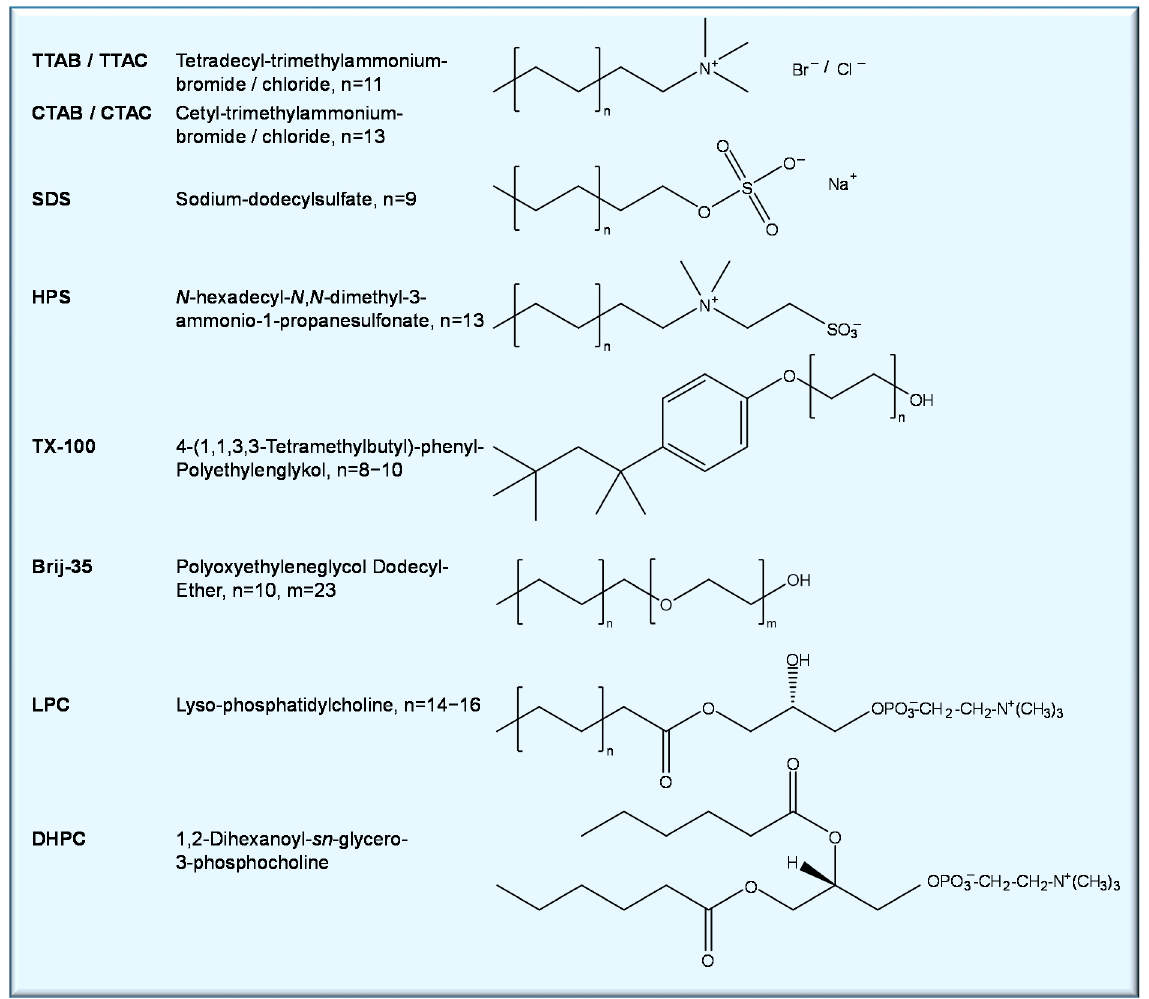
Figure 9. Structures of micelle forming surfactants.